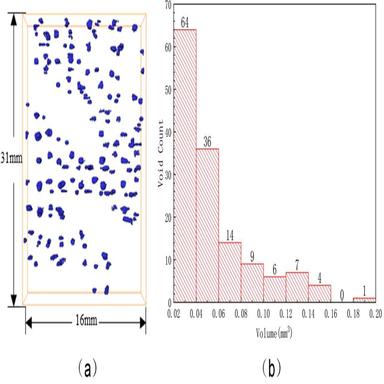
Void defect statistical analysis: (a) Three-dimensional reconstruction of void defects; (b) Volume statistical histogram of void defects.